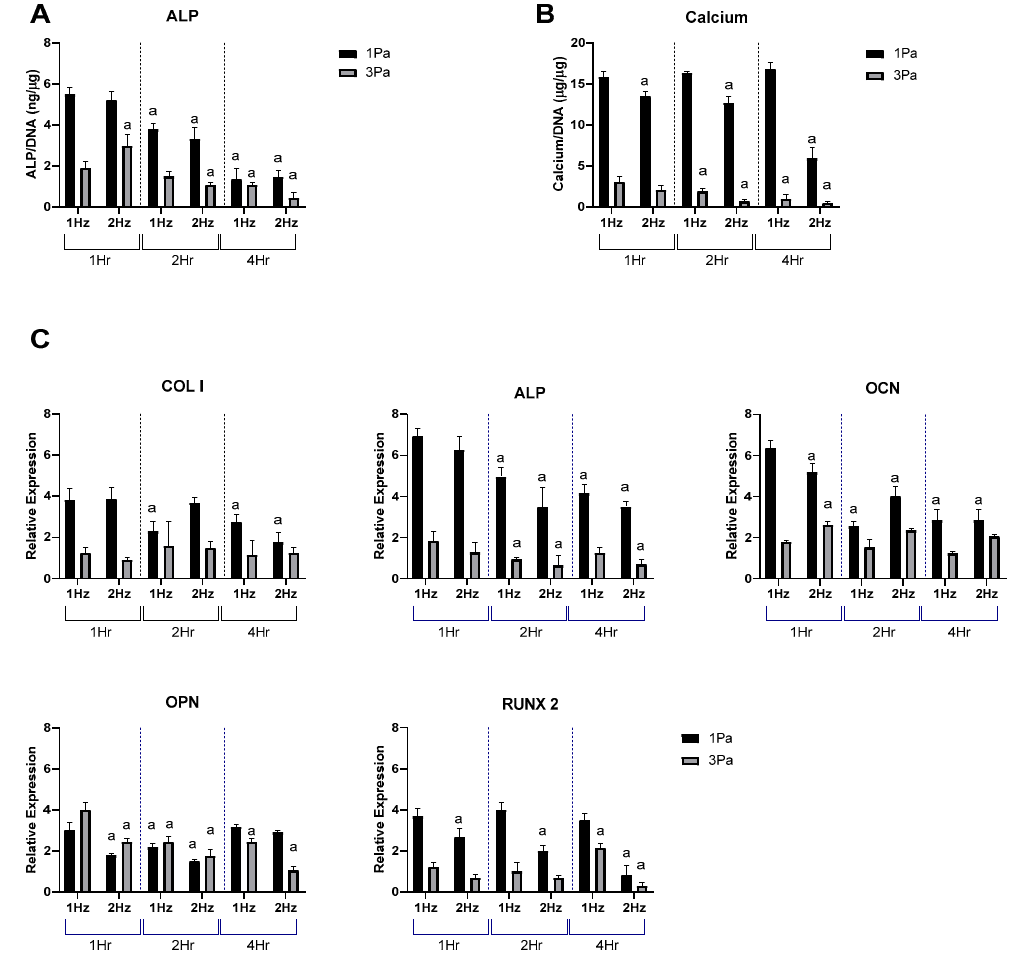
Figure 2. Effect of frequency and duration of FFSS conditions on MSC-OBs at 1 and 3 Pa in terms of ALP, calcium and osteogenic gene expression. ( A ) ALP levels normalized to DNA content. ( B ) Calcium levels normalized to DNA content. ( C ) Gene expression levels for Collagen I, ALP, OCN, OPN and RUNX2 mRNA in MSC-OBs via RT-PCR. Expression data were calculated using the 2 − ∆∆ Ct method relative to baseline levels and normalized using 18S as endogenous control. Statistical differences are shown where (a) represents significant difference compared with conditions at the same stress level at 1 Hz and 1 h, to the level of p <